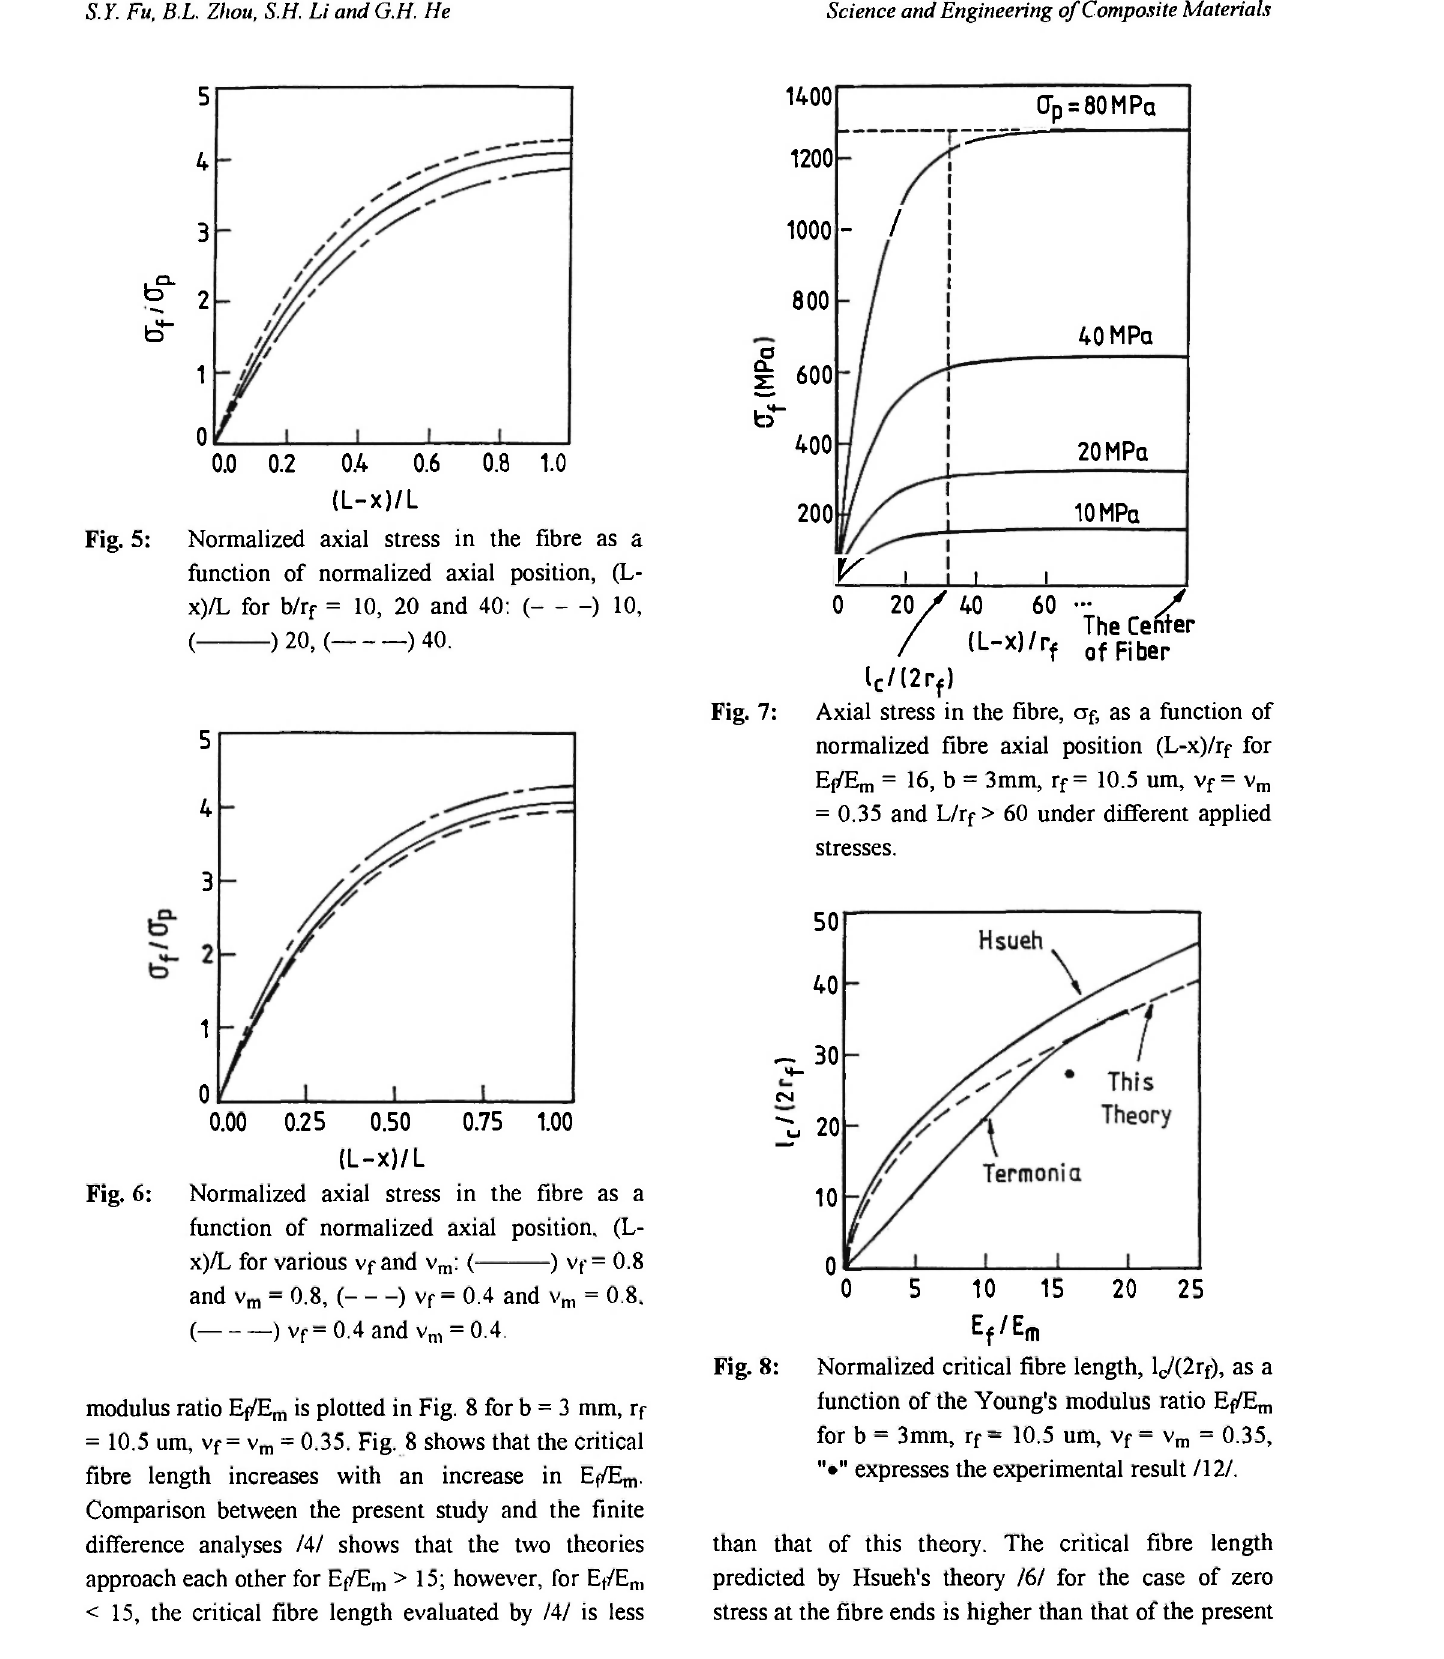
Fig. 8: Normalized critical fibre length, lc/(2rf), as a function of the Young's modulus ratio Ef/E m for b = 3mm, rf = 10.5 um, Vf = v m = 0.35, "·" expresses the experimental result /12/. than that of this theory. The critical fibre length predicted by Hsueh's theory 161 for the case of